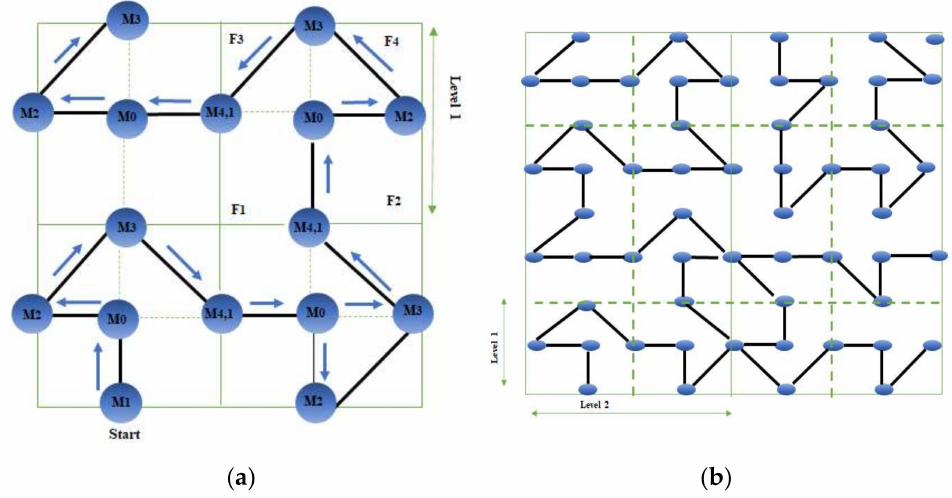
Figure 8. ( a ) Arrow-Curve path model (le = 2); ( b ) Arrow-Curve path model (le =